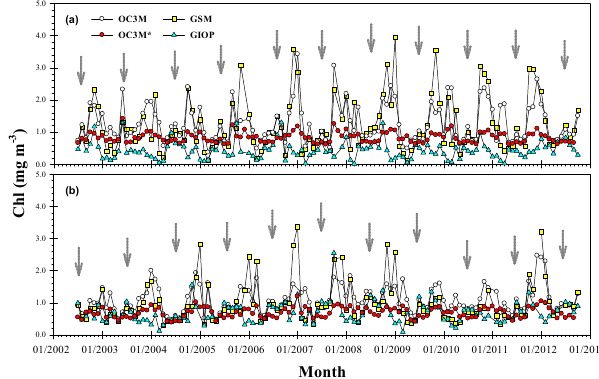
Fig. 7. Monthly variations of MODIS Chl in the Qiongdong (a) andYuedong (b) upwelling zones; arrows indicate summer.